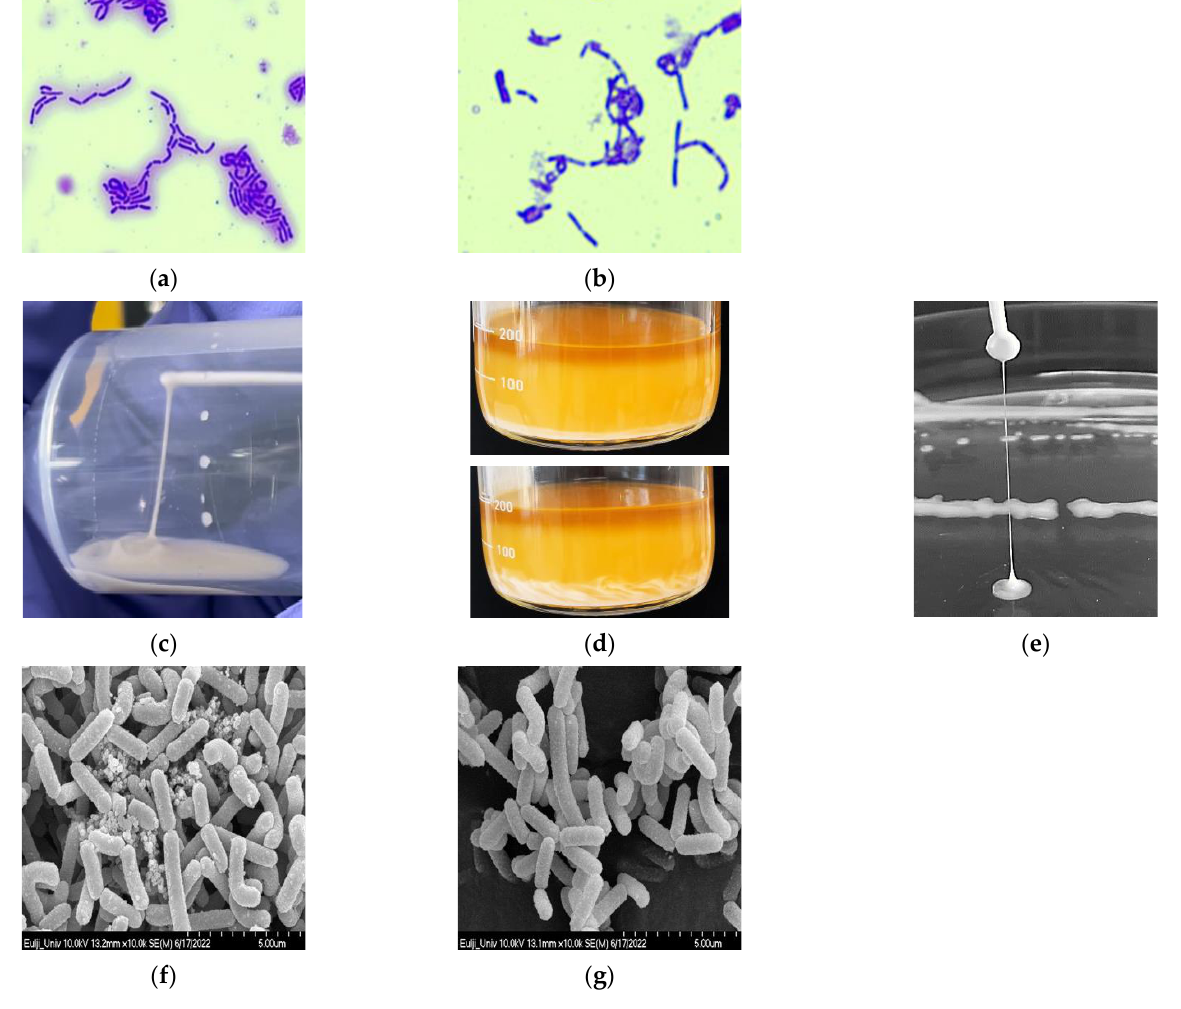
Figure 1. Visualization of EPS produced by L. paracasei EPS DA-BACS. ( a ) Crystal violet staining of L. paracasei EPS DA-BACS culture; ( b ) Crystal violet staining of L. paracasei EPS DA-BACS culture after centrifugation; ( c ) Ropiness of L. paracasei EPS DA- BACS’s culture broth; ( d ) Separation of L. paracasei EPS DA- BACS’s culture broth layer; ( e ) Ropiness of L. paracasei EPS DA- BACS’s colony; ( f ) Scanning electron microscopy image of L. paracasei EPS DA-BACS culture without removal of EPS;